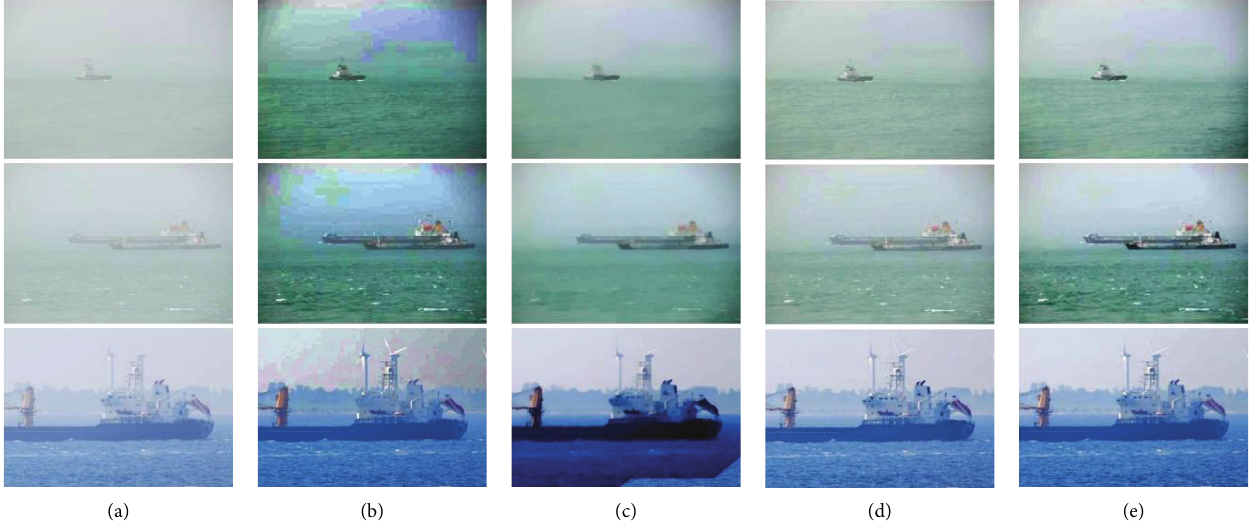
Figure 9: Visual comparisons of realistic experiments on three haze images. From left to right: (a) real haze image and dehazed images generated by (b) DCP [23], (c) RIVD [30], (d) MSCNN [12], and (e) ours,